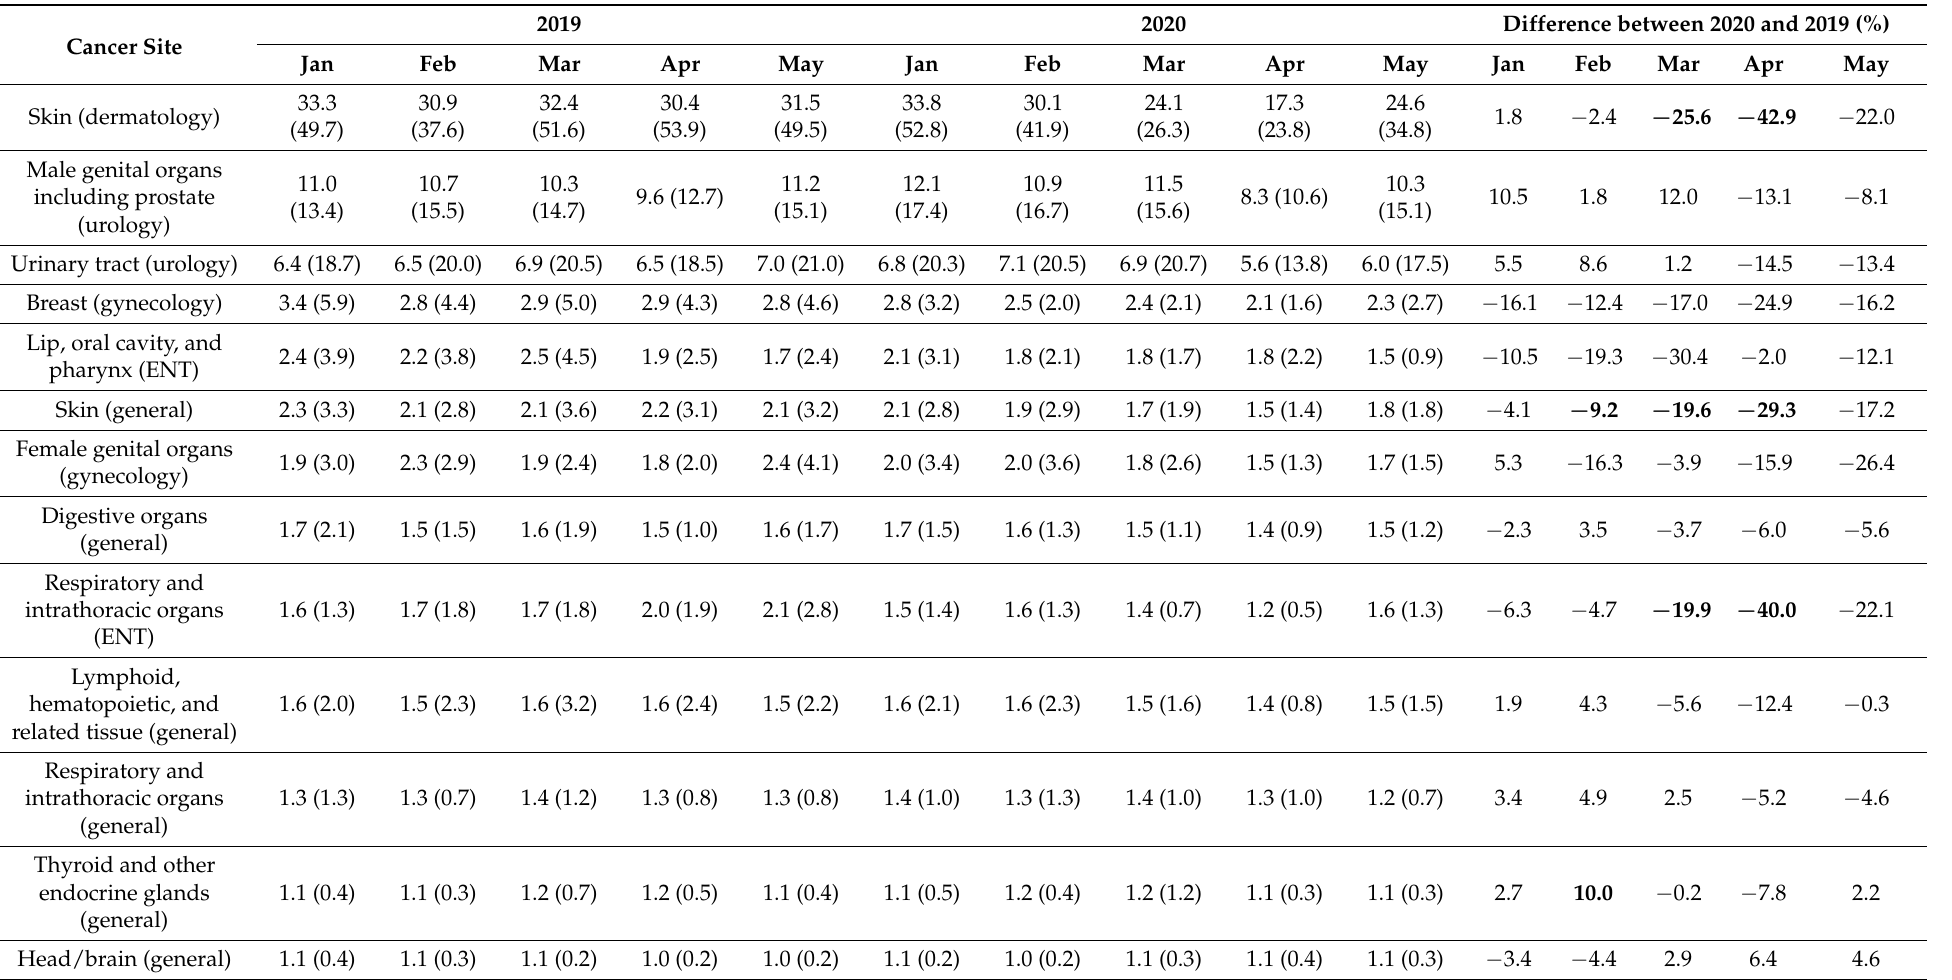
Table 3. Differences by cancer site in the number of new cancer diagnoses per practice in Germany between January and May 2020 and January and May 2019. Cancer